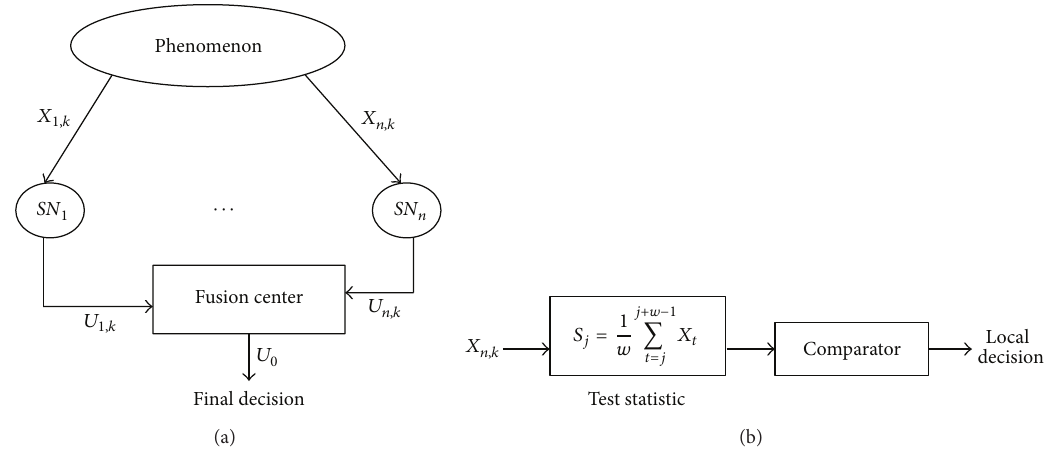
Figure 1: (a) Change detection in a decentralized setting. (b) Structure of local detectors.